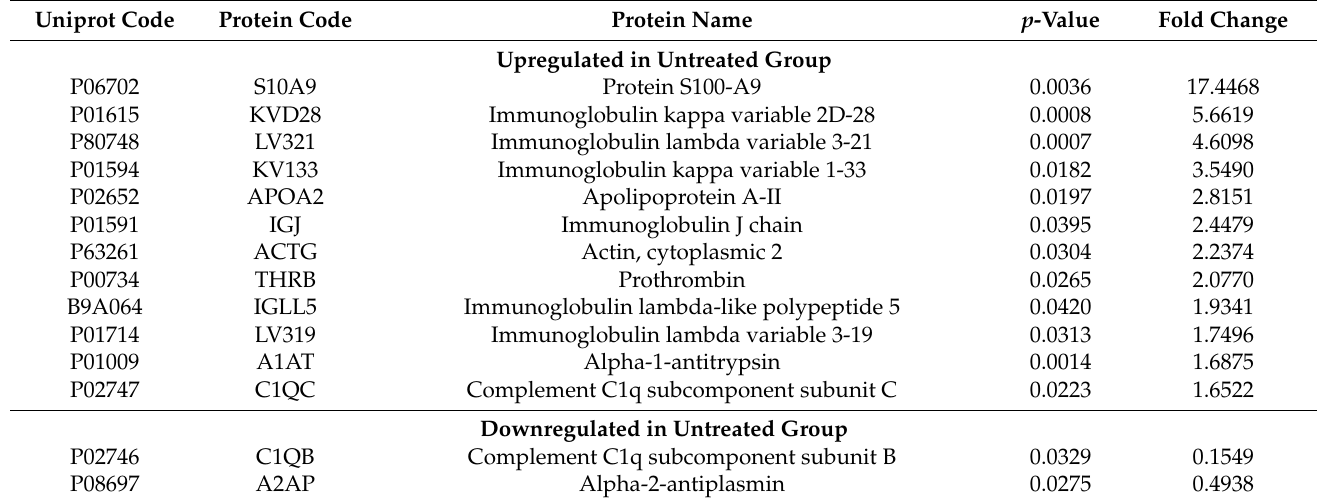
Table 3. Changes in protein expression in the untreated group relative to all other groups. Protein expression is considered altered in cases in which p < 0.05 and the fold change >1.5 (upregulated proteins) or <0.6 (downregulated proteins).